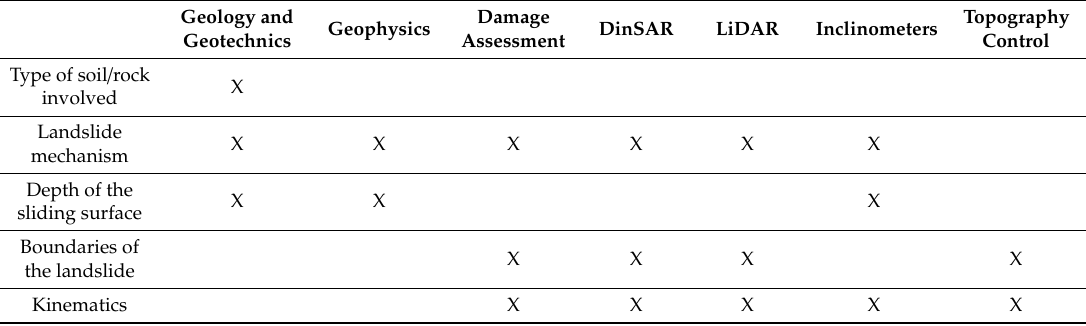
Table 2. Contribution to the understanding of the landslide by the di ff erent techniques